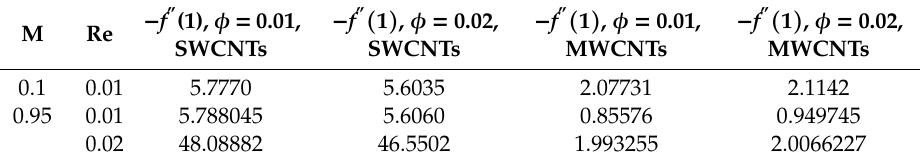
Table 4. The impact of M , Re, φ , versus skin friction. When Pr = 6.7, β = 1.1.